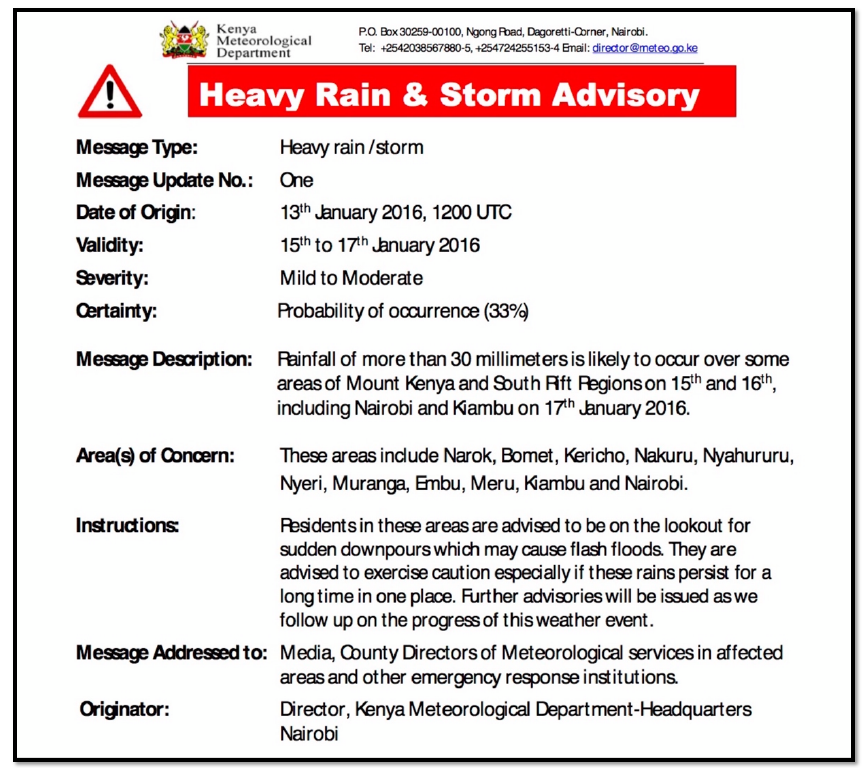
Figure 1. An example of a heavy rainfall advisory issued by the KMD.